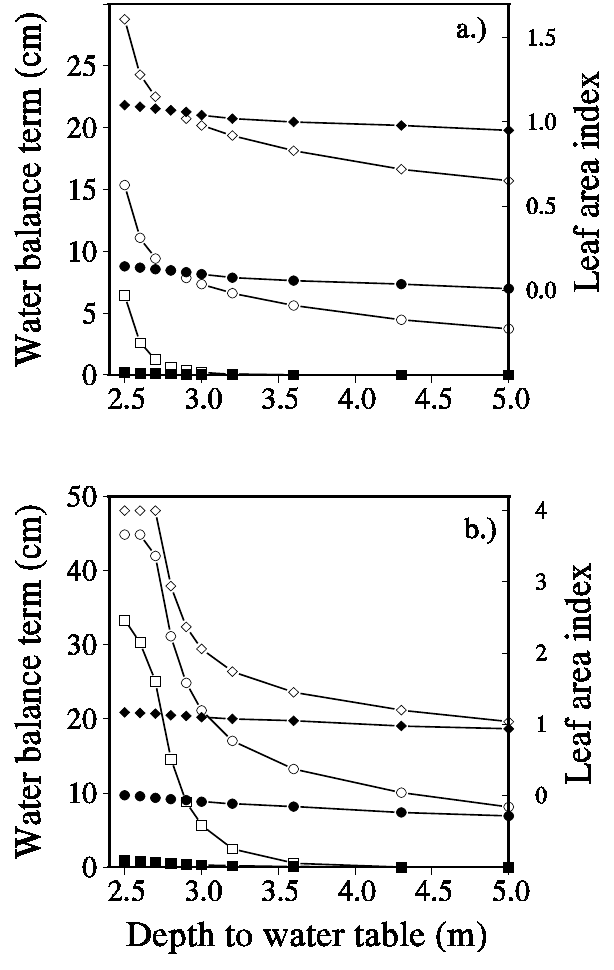
Fig. 5. Leaf area index (diamonds), transpiration (circles) and cap- illary rise (squares) simulated by compensated (Eqs. 1 to 4 and 17, open symbols) and uncompensated (Eqs. 14 and 19, solid symbols) models as a function of water table depth during a 100-day dry- down period for (a) a loamy soil and (b) a sandy soil. Parameter values are given in Table 1, initial/boundary conditions in the